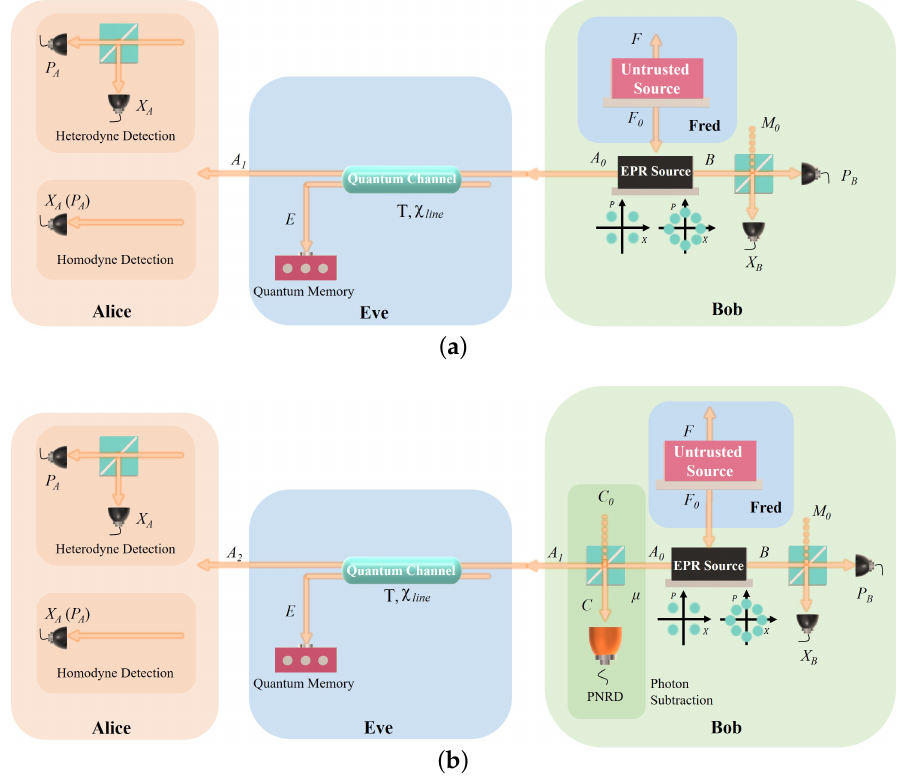
Figure 2. ( a ) the EB scheme of PP DM-CVQKD protocol. Here, Fred is assumed to controlled by Eve, and he will introduce an untrusted source noise; ( b ) the corresponding PS-based PP DM-CVQKD scheme. PNRD, photon number resolving